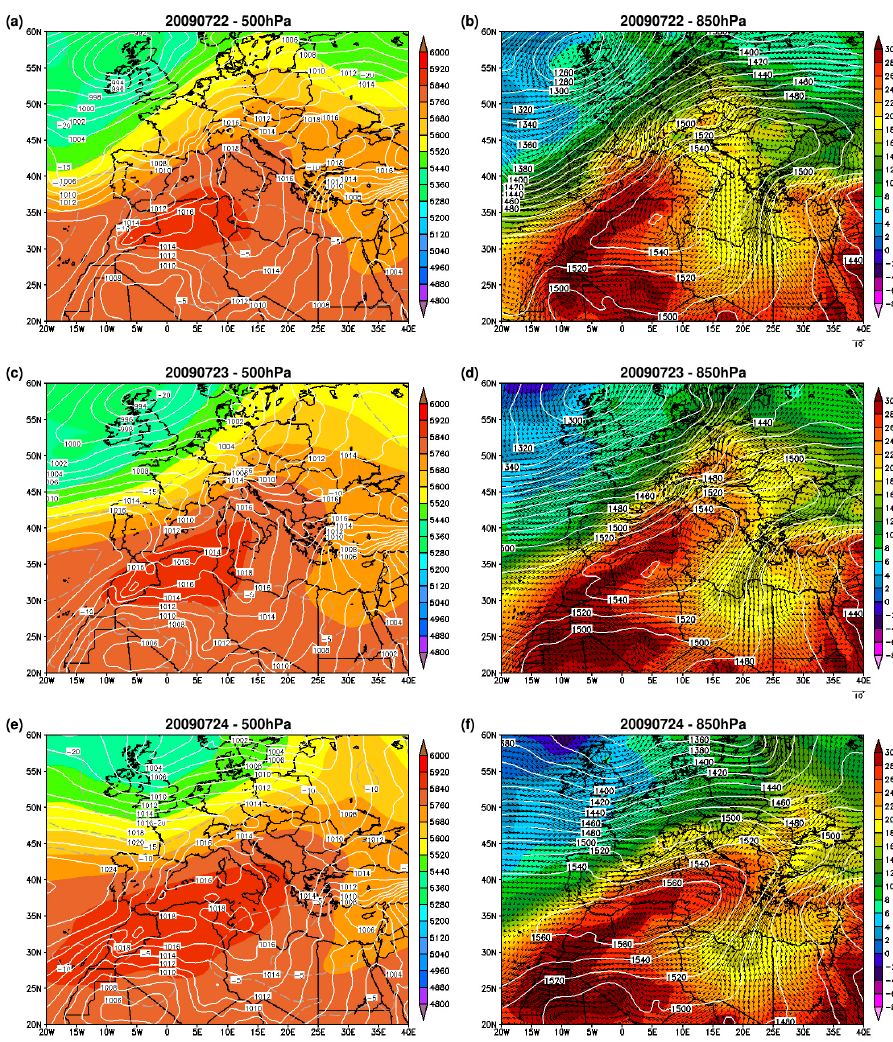
Figure 3. ( a – f ) Sea level pressure (hPa, solid line), geopotential height (gpm, shaded color) and temperature in °C (dashed line) at 500 hPa from ERA-Interim reanalysis global model at 12 UTC on 22 July ( a ); 23 July ( c ) and 24 July 2009 ( e ); and Temperature (°C, shaded), wind (arrows) and geopotential height (gpm, contoured) at 850 hPa on 22 July ( b ); 23 July ( d ) and 24 July 2009 ( f ).